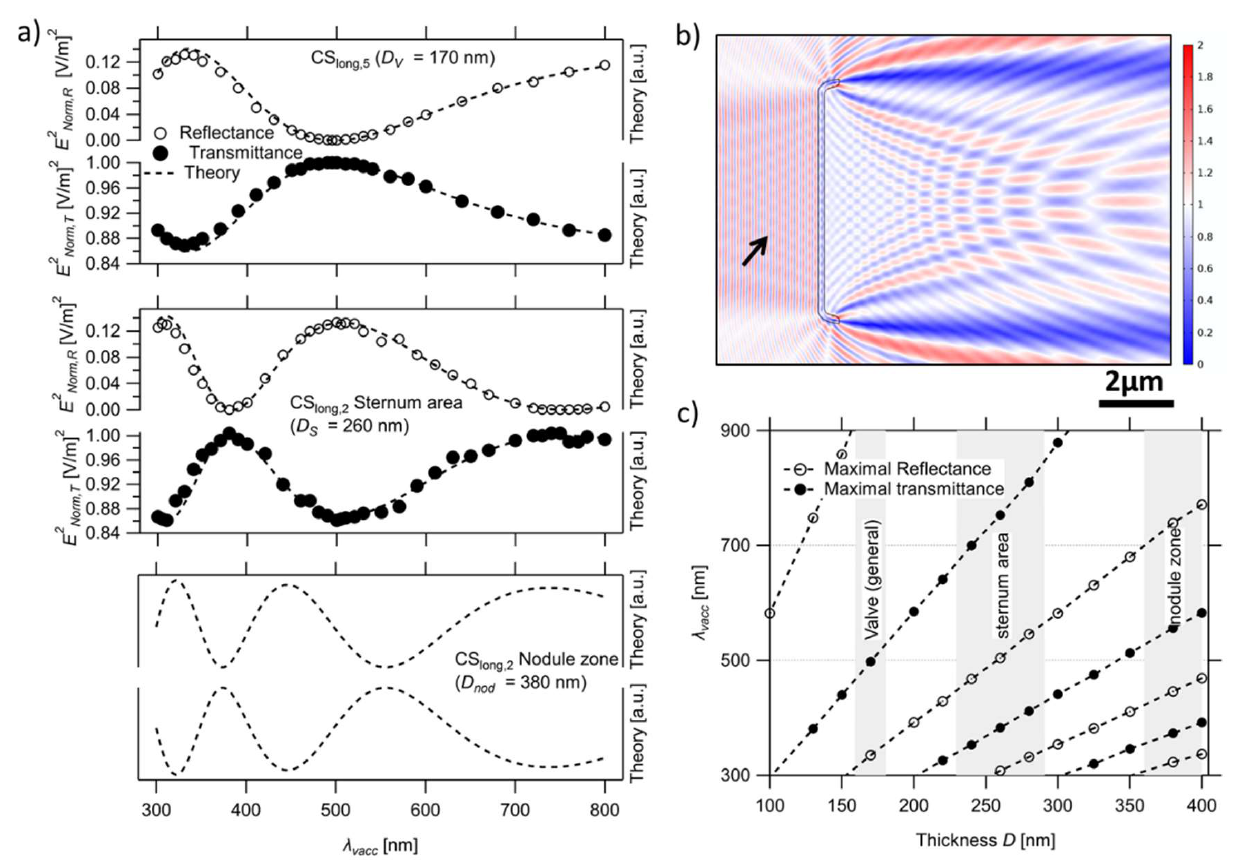
Figure 3. ( a ) The plots show the extracted E 2Norm,R and E 2Norm,T of CS long,5 and CS long,2 compared to the theoretical calculation for the studied λ vacc range. The estimated error in the extracted E Norm is up to ± 0.006 or ± 0.01 V/m in CS long,5 or CS long,2 , respectively. ( b ) CS long,5 shows the maximum constructive interference at reflectance ( λ vacc = 330 nm); the black arrow indicates the formation of standing waves between the reflected and the incident wavefronts. ( c ) The dependency of λ vacc positions of the constructive interference maxima on D sl . The grey-shaded areas in ( c ) show the significant error in the thickness of different valve parts (Table 1).